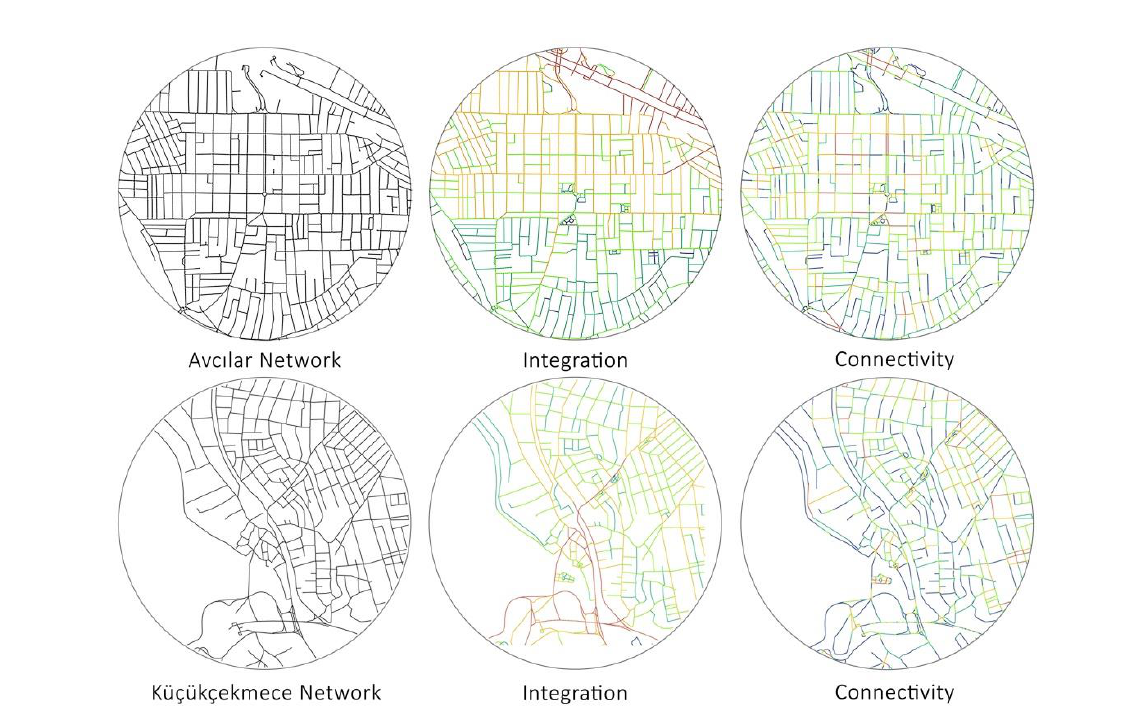
Figure 4 Avcılar and Küçükçekmece square-areas (800 meter circular buffer) represented with street network centerlines, Integration (n), and Connectivity